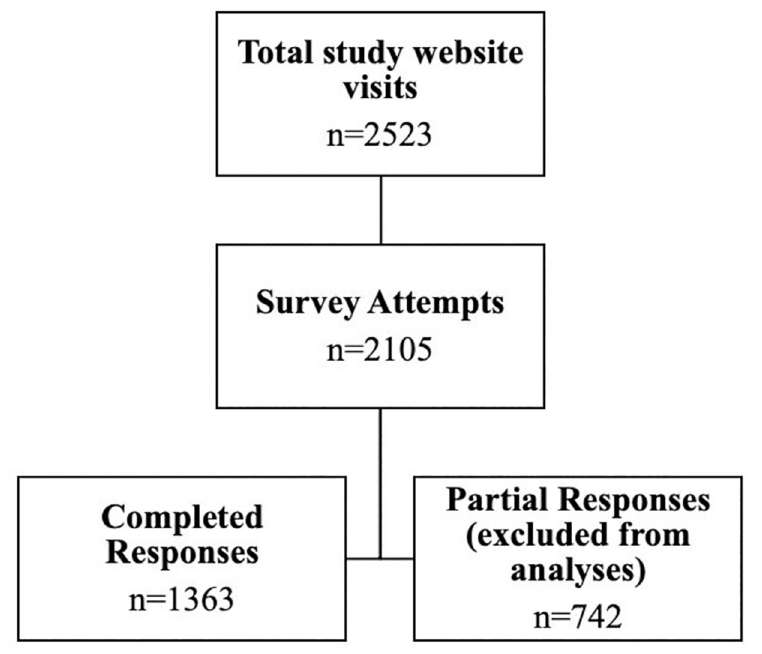
Fig 1. Flowchart of the participant inclusion